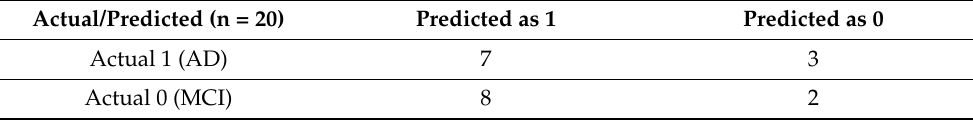
Table 9. Confusion matrix of AD/MCI classification with the hippocampal